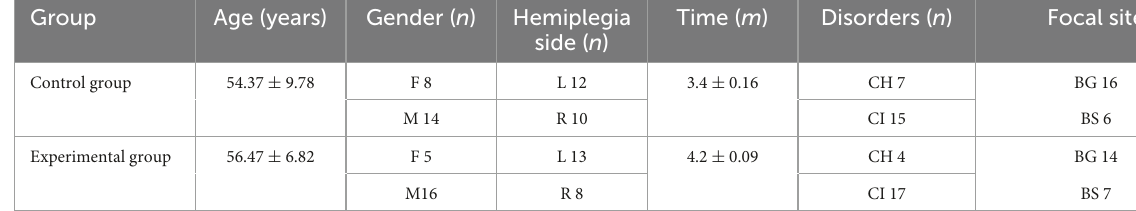
TABLE 2 Baseline characteristics of active and sham